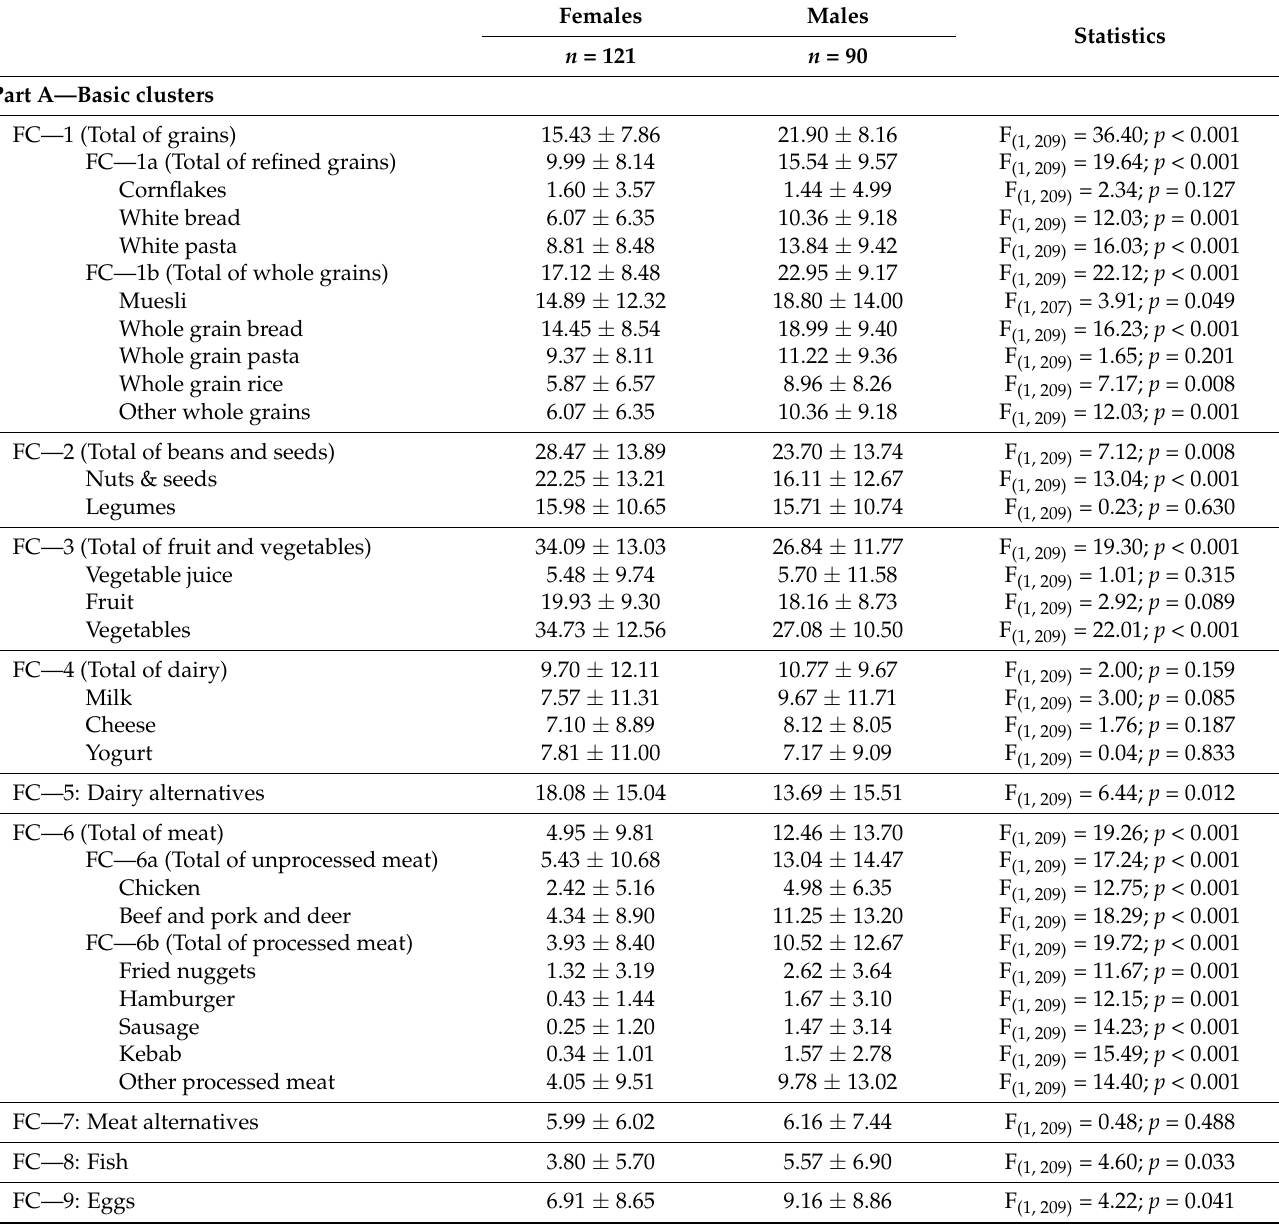
Table 3. Differences between female and male runners in food clusters and